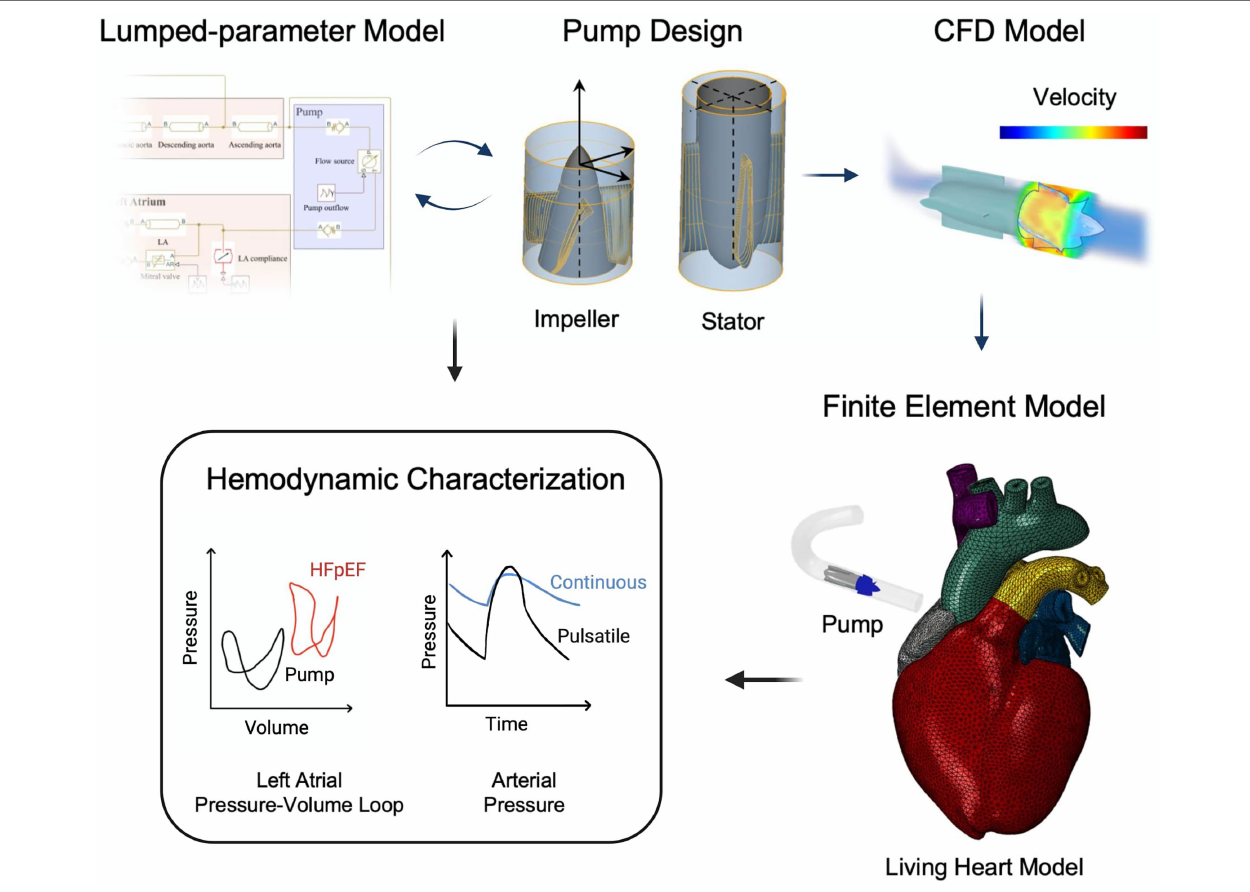
FIGURE 2 | Workflow of pulsatile pump design and characterization. A lumped-parameter model is used for the optimization of the pump flow characteristics. CFD modeling enables evaluation of pump performance and hemocompatibility. Finally, integration of the pump into the finite element Living Heart Model allows comprehensive investigation of the resulting hemodynamics and comparison with findings from the lumped-parameter